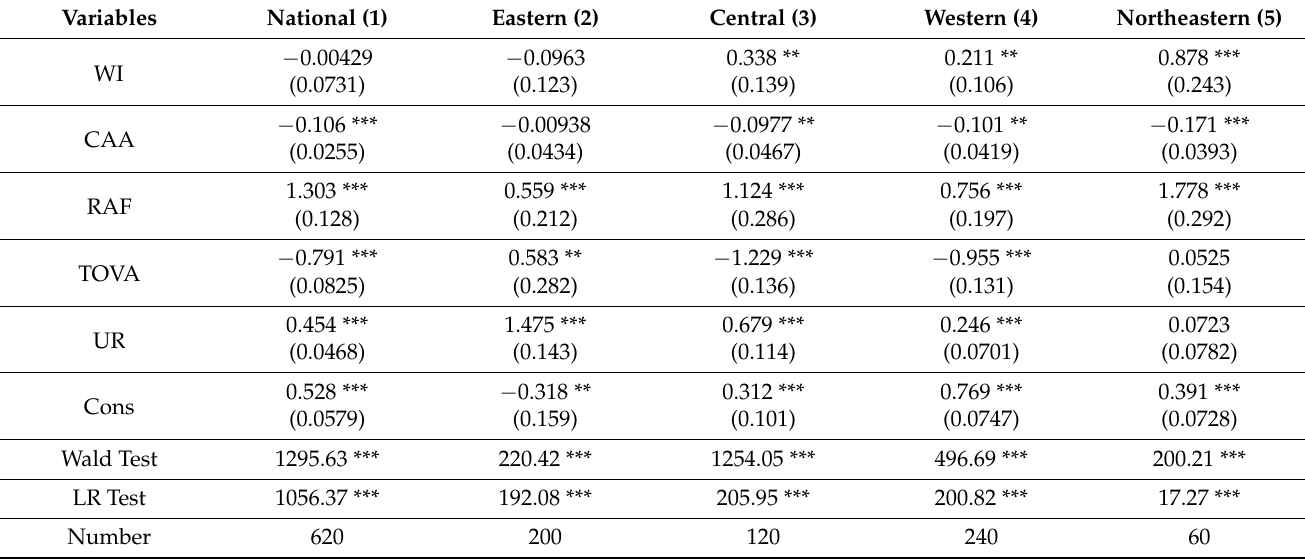
Table 5. Panel Tobit regression results and